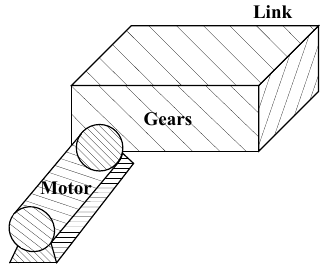
Figure 1. Single-link manipulator.